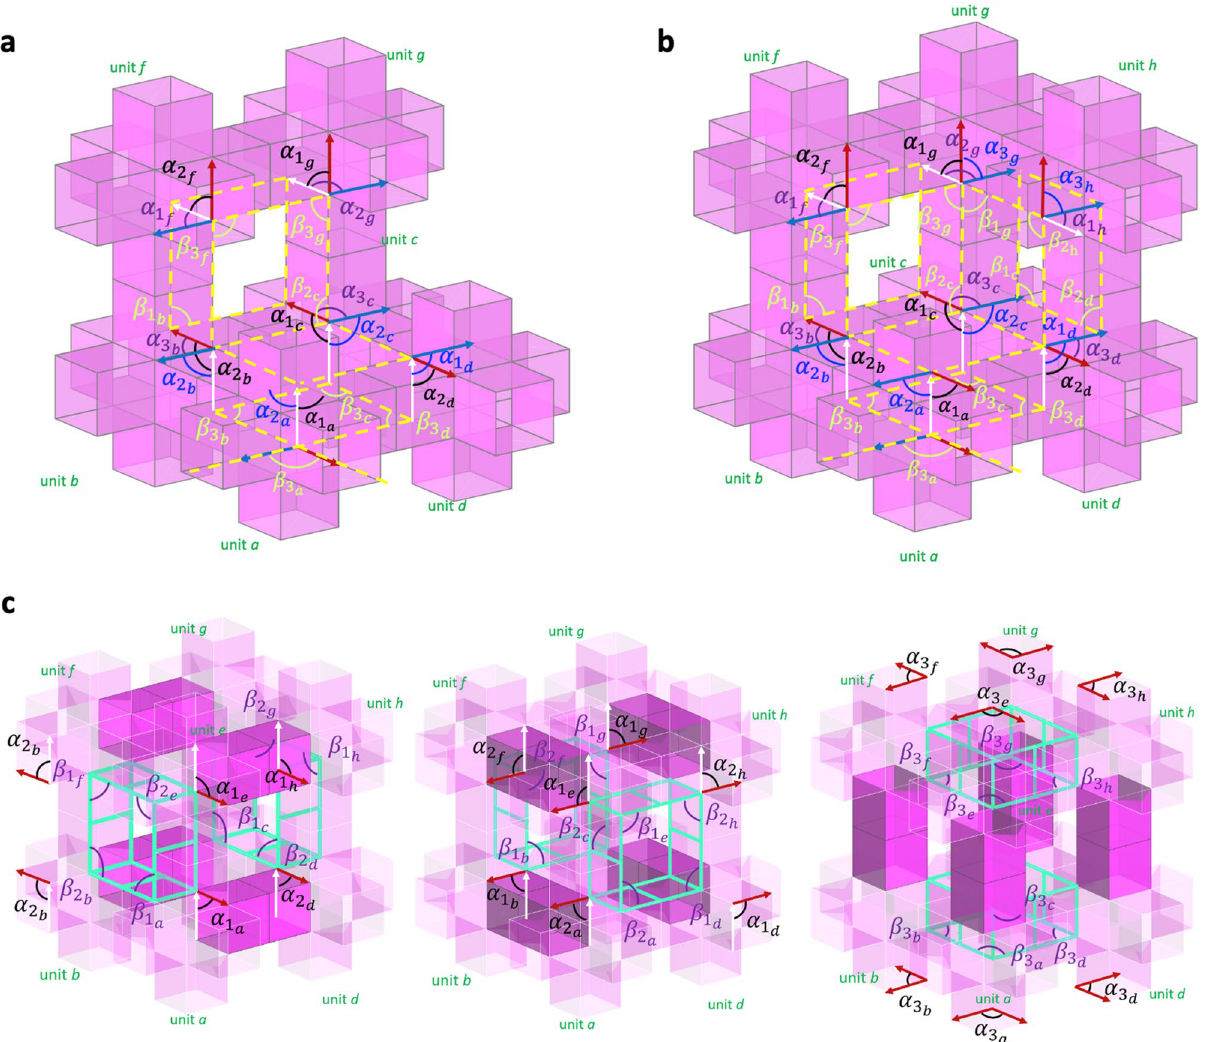
Figure 5. Angular kinematics to determine mobility of extended unit cells with planar closed-loops for spatial tessellation: ( a ) extended unit cell with two planar closed-loops, ( b ) extended unit cell with three planar closed- loops, and ( c ) extended unit cell with six planar